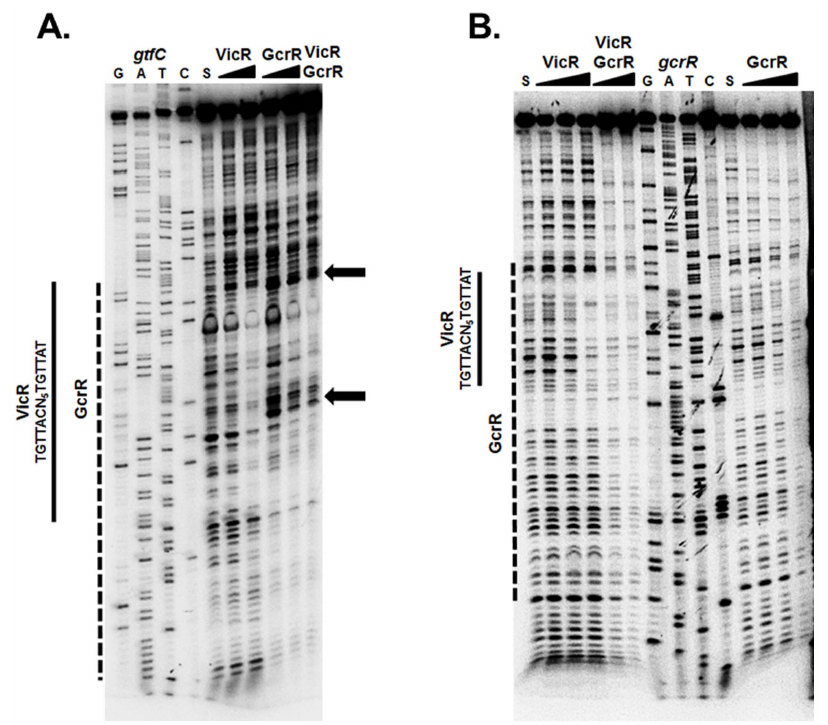
Fig. 4. DNaseI footprinting of the gtfC and gcrR promoter regions. (A) VicR or GcrR at increasing concentrations (0.25 and 0.5 m M) or a combination of VicR and GcrR at an equimolar concentration (0.5 m M) were incubated with labeled gtfC DNA substrate. The S above the fifth lane indicates the DNA substrate incubated in the absence of VicR/GcrR. The arrows designate the areas of enhanced cleavage by DNaseI. (B) Labeled gcrR DNA substrate was incubated with increasing concentrations of VicR or GcrR (0.125, 0.25, and 0.5 m M) or a mixture of VicR and GcrR at equimolar concentrations (0.25 and 0.5 m M). The S above the first and eleventh lanes indicates the DNA substrate incubated in the absence of VicR/GcrR. The solid line represents the region of protected nucleotides by VicR and the dashed line represents the region of protection by GcrR. The VicR consensus sequence is shown to the left of the solid